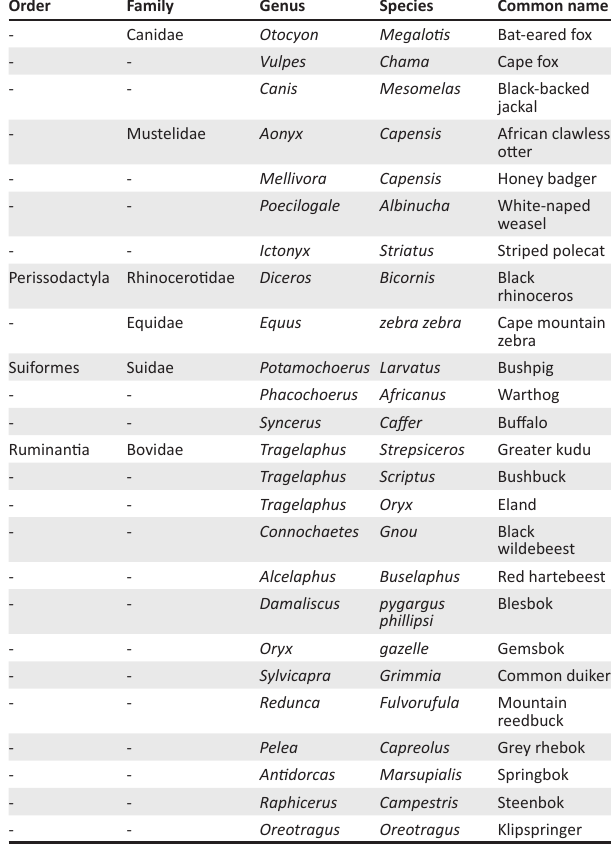
TABLE 1-A1 (Continues...): The updated (2020) checklist of 68 mammal species in the Mountain Zebra National Park, Eastern Cape, South Africa. See text for details on the criteria used for